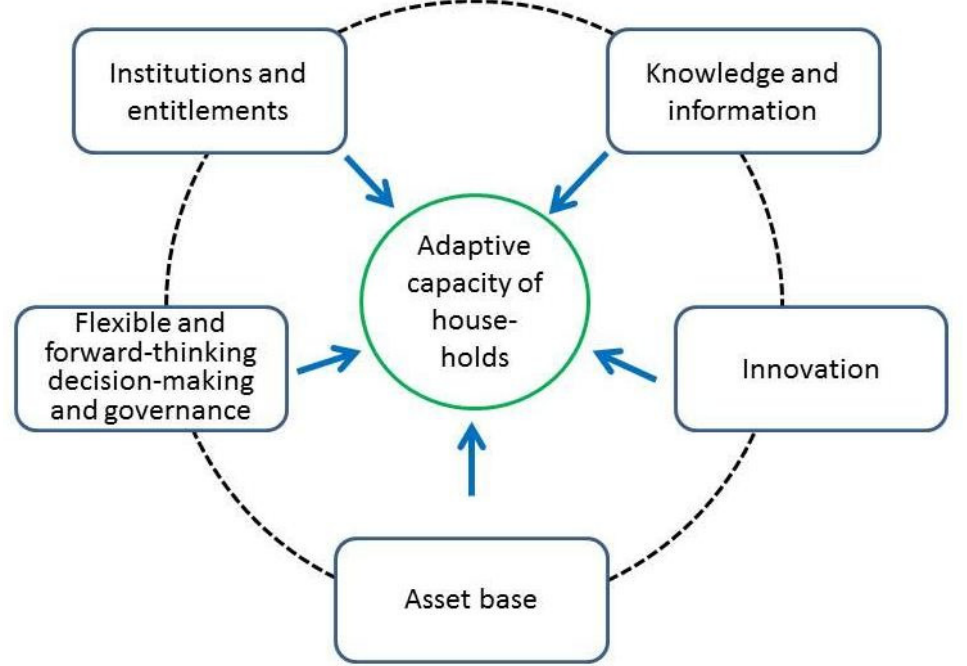
Figure 2. Conceptual framework for assessing the adaptive capacity of households. Source: Adapted from Jones et al. [17]. Arrows indicate direct e ff ects, while the broken circle depicts secondary or indirect relationships between the